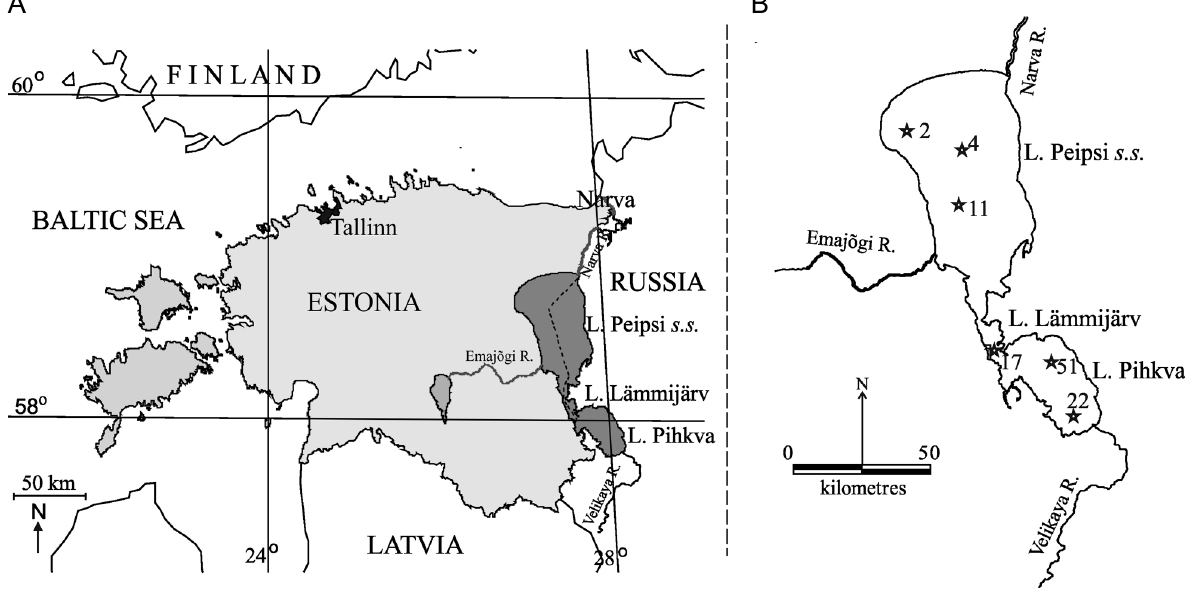
Fig. 1. Location of Lake Peipsi ( A ) and sampling stations ( B